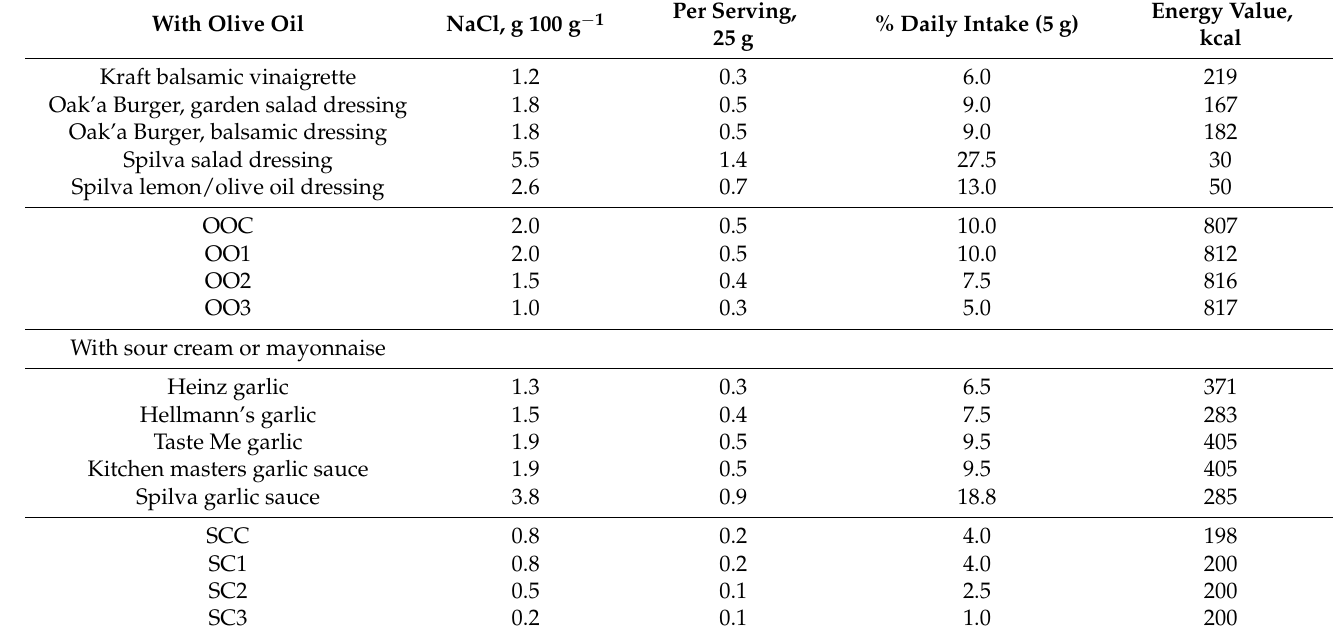
Table 4. Salt content and energy value in commercially available salad dressings and garlic